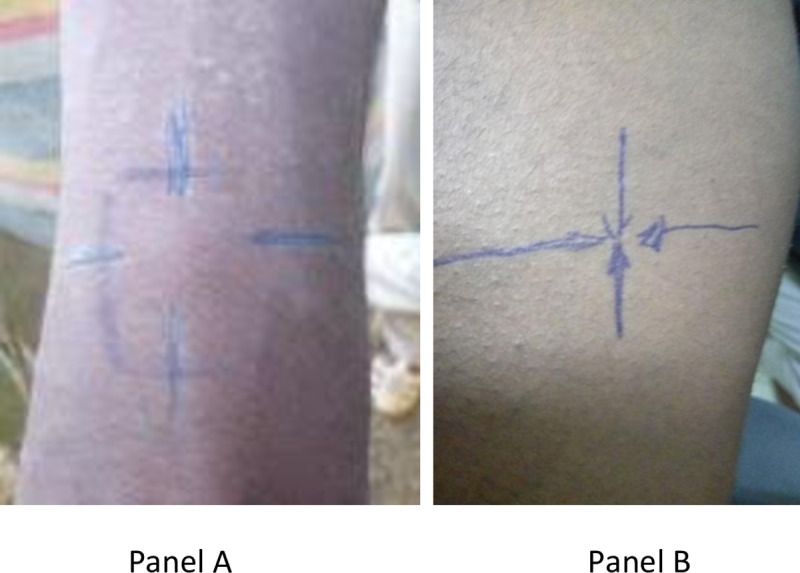
Positive (panel A) and Negative (panel B) LST reactions.